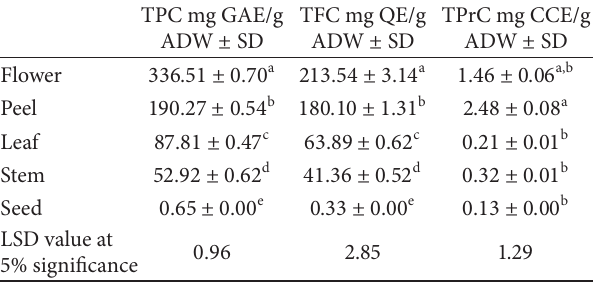
Table 1: Total phenolics, total flavonoids, and total proanthocyani- din content of pomegranate parts extracts.